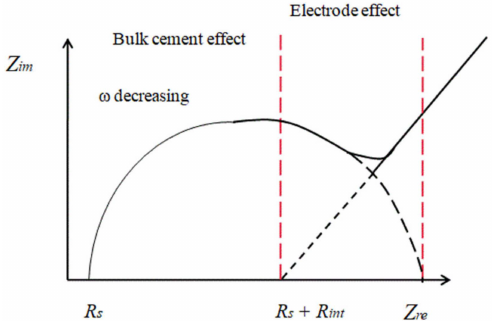
Figure 11. Nyquist